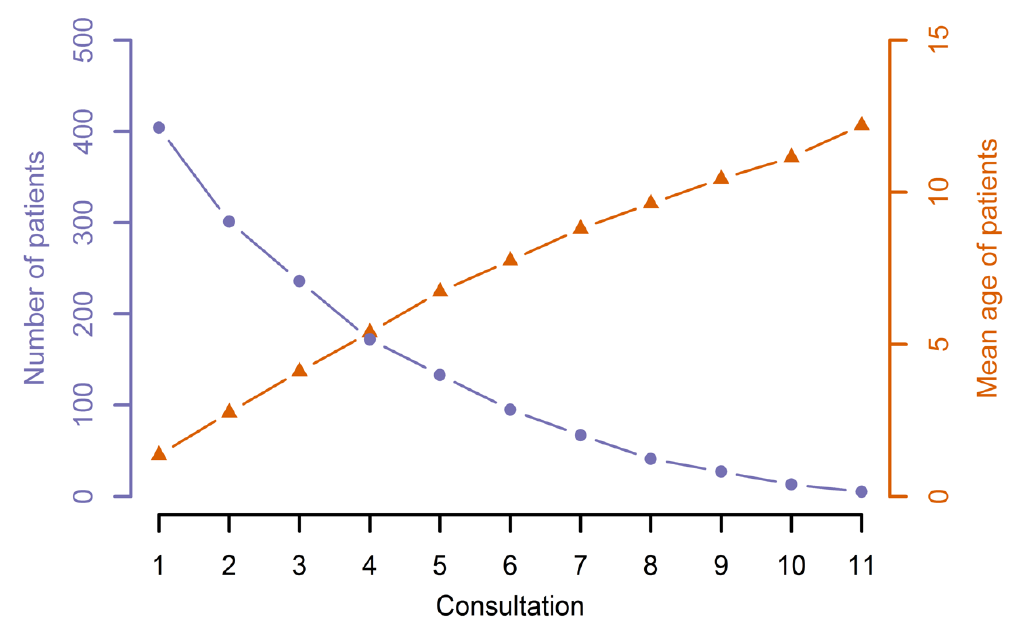
Figure 2. Follow-up visits and mean age of patients born during our investigation period.